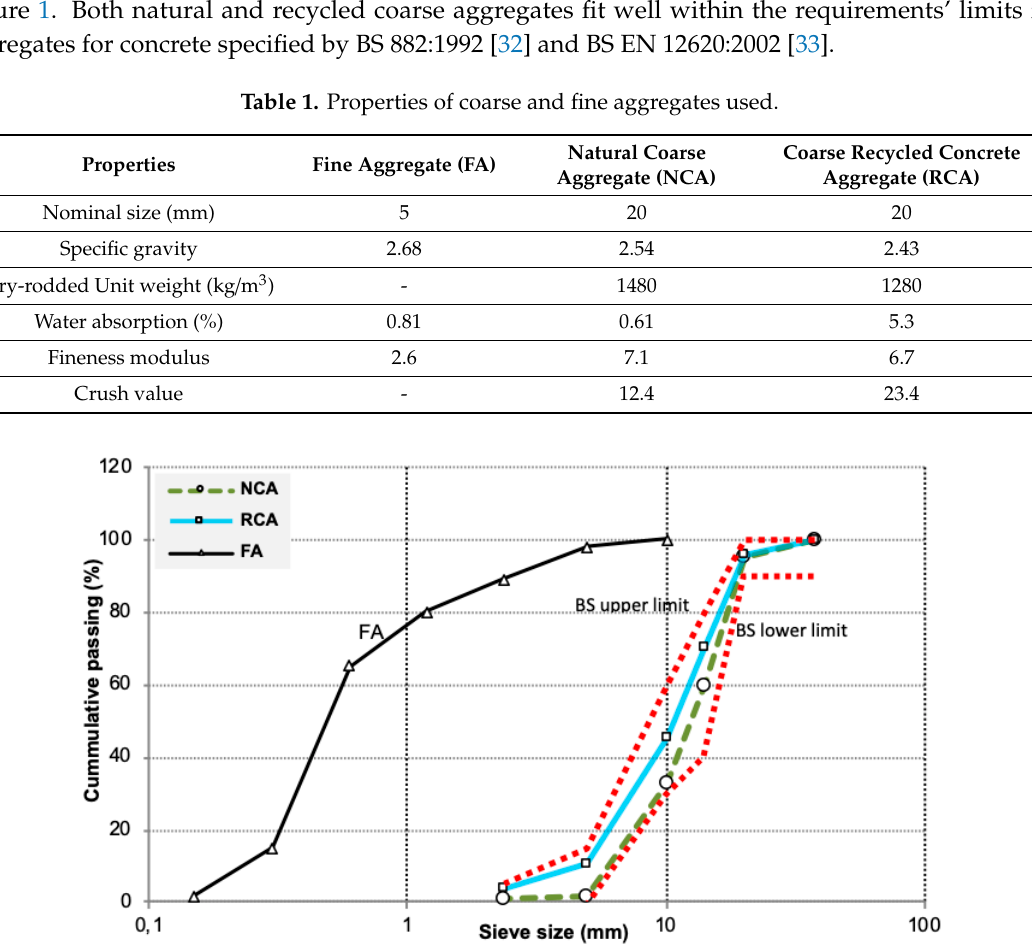
Figure 1. Gradation of natural and recycled aggregates used. NCA: Natural coarse aggregates; RCA: recycled concrete coarse aggregates; FA: sand.